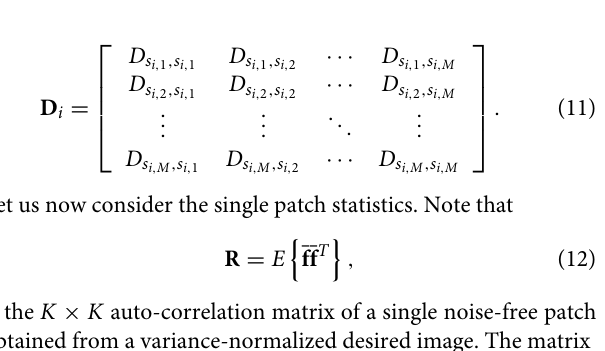
FIGURE 10 | The PSNR for AWF, CAWF, and the bicubic outputs with different levels of noise. (A) σ η results are obtained with M